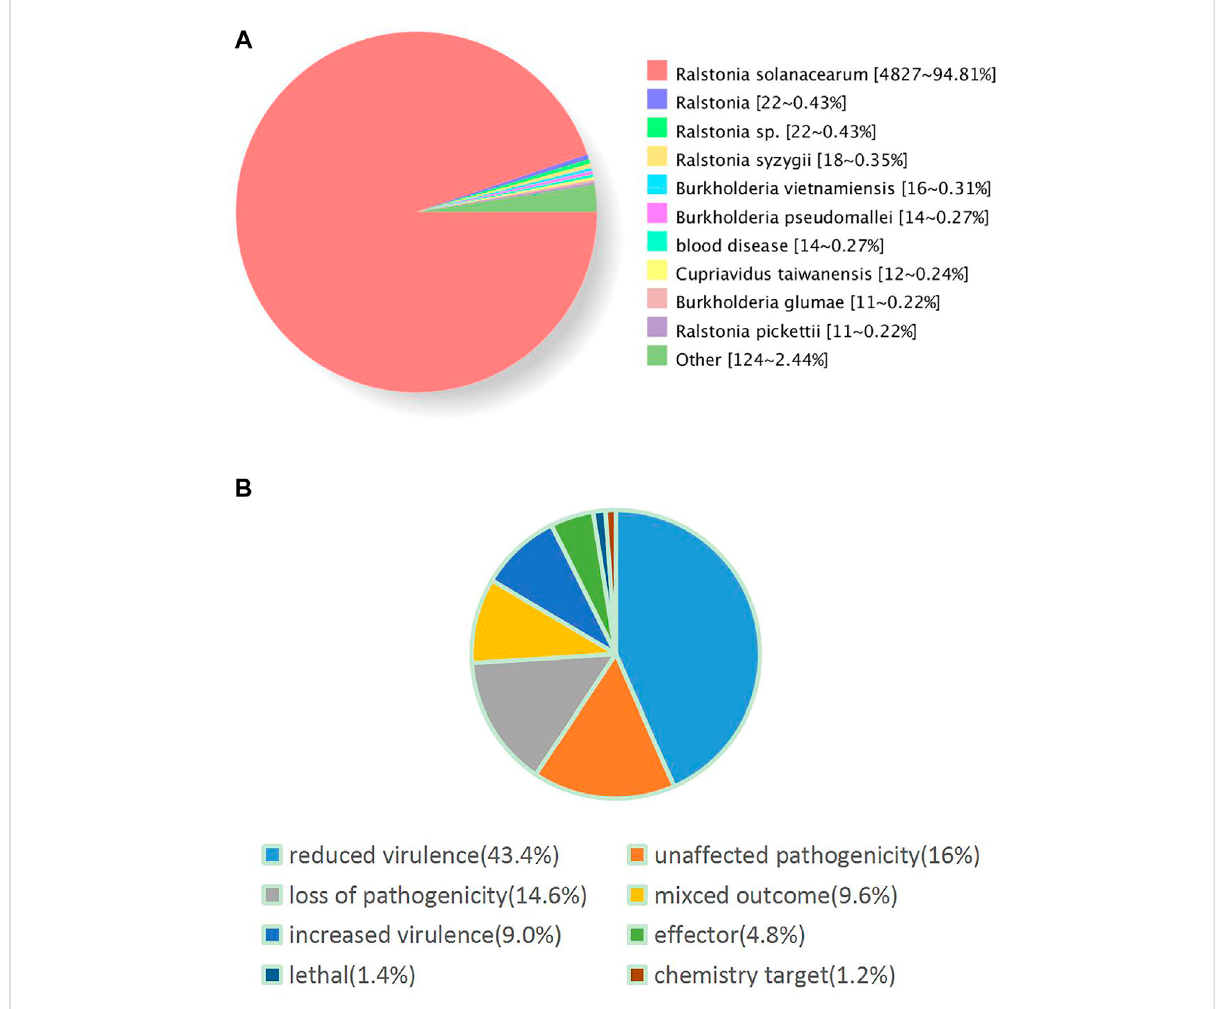
FIGURE 3 EnrichmentanalysisresultsbasedontheNRandPHIdatabases. (A) StatisticalresultsofspeciesdistributionbytheNRdatabase.Differentcolors represent different homologous species. (B) The gene enrichment annotation to the PHI database. Different colors represent different types of disease-related